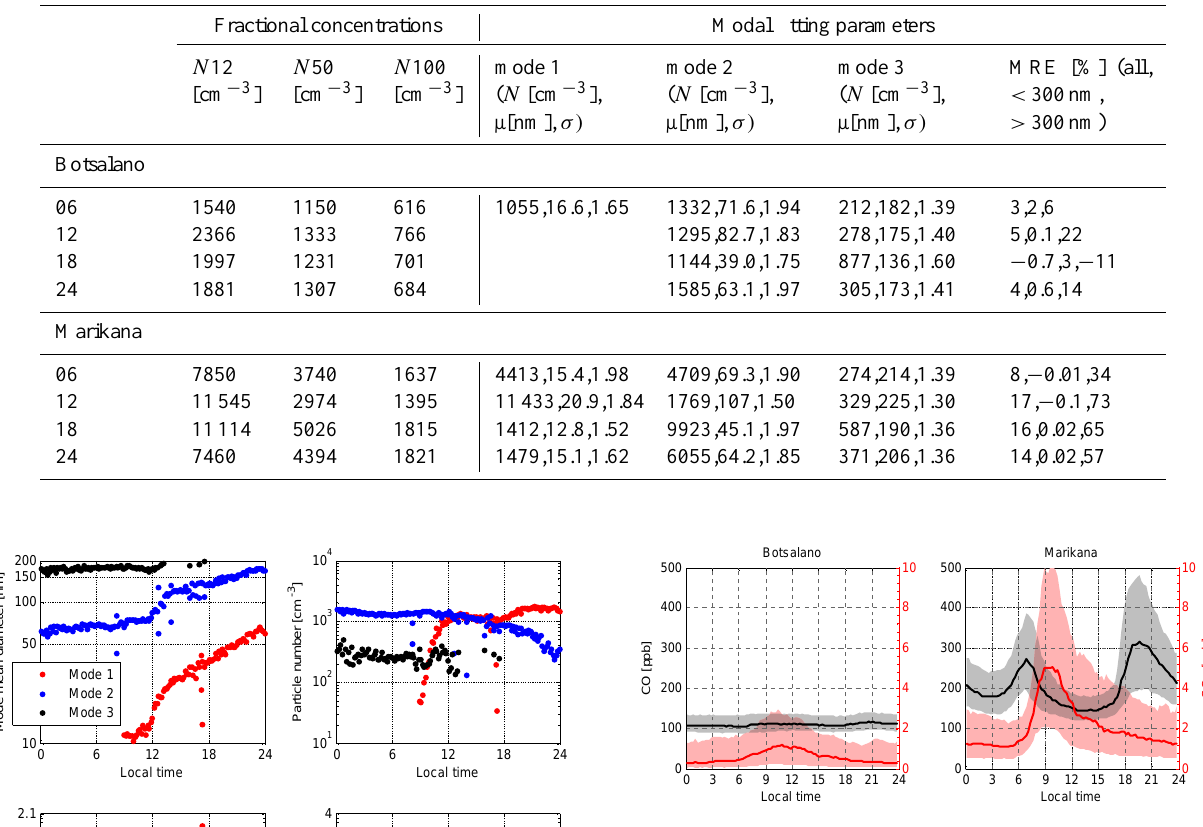
Fig. 6. Median SO 2 and CO diurnal variations for Botsalano and Marikana. Shaded areas indicate the upper and lower